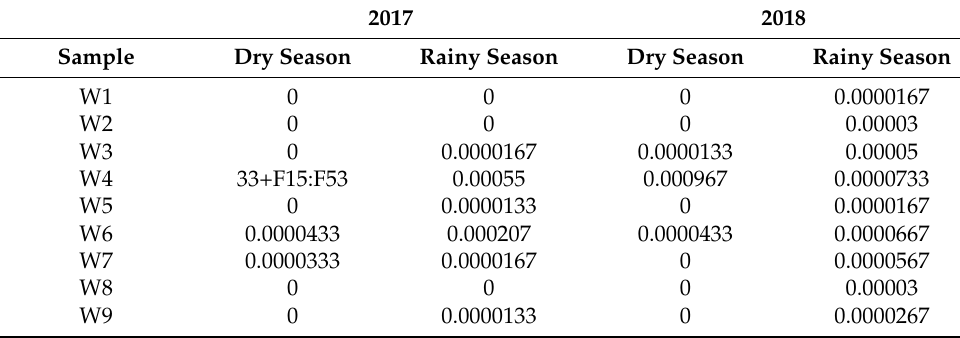
Table 6. Non-carcinogenic risk assessment for